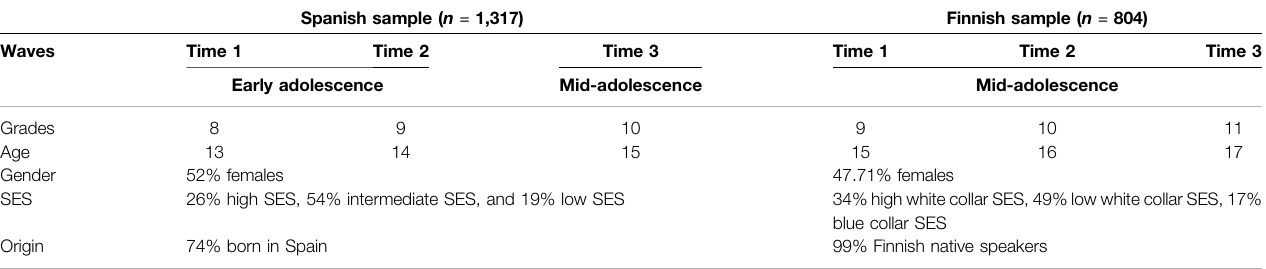
TABLE 1 | Sample characteristics for the Spanish and Finnish